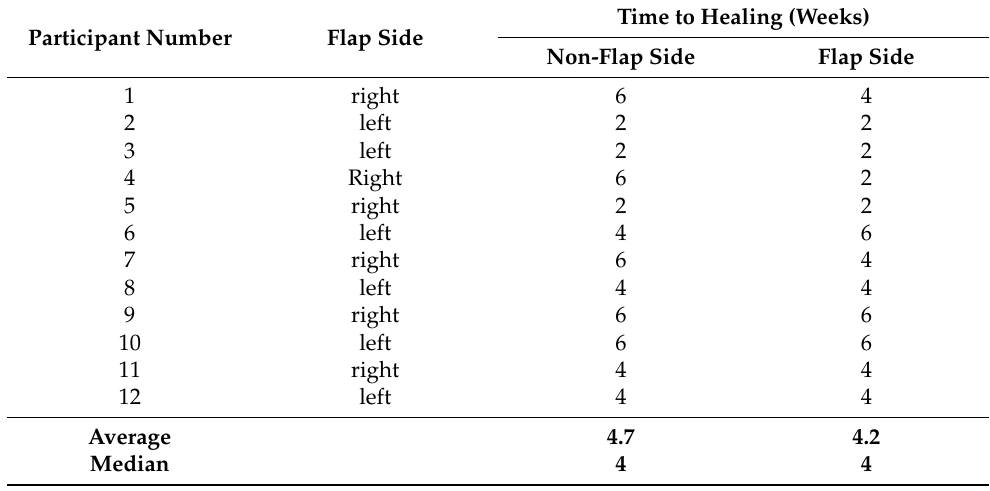
Table 1. Healing time (weeks) when comparing flap side to non-flap